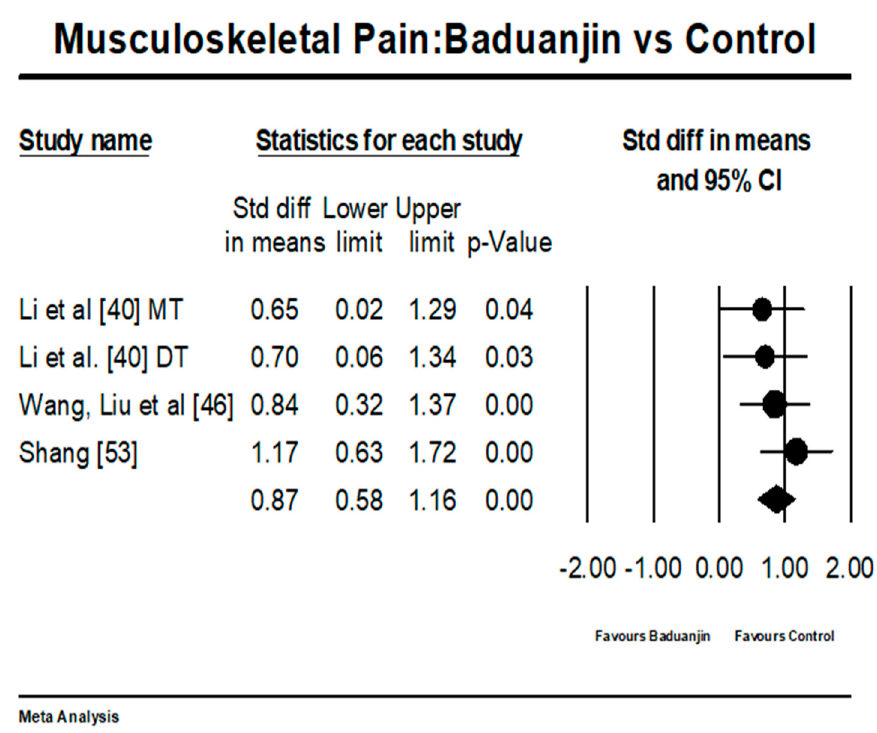
Figure 3. Effect of Baduanjin on musculoskeletal pain (Condition 2); MT = manual therapy; DT = drug therapy).